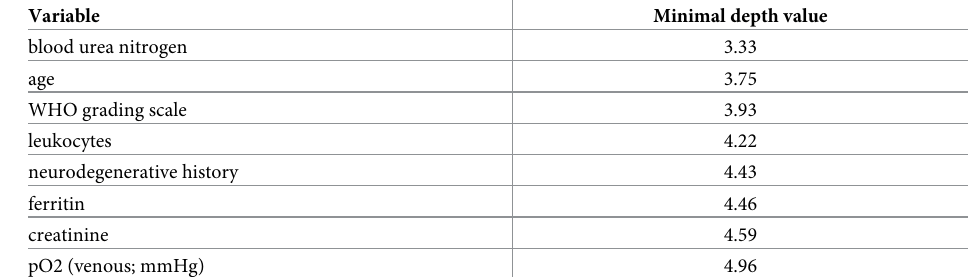
Table 3. Strong predictors of the occurrence of delirium selected by a random-forest